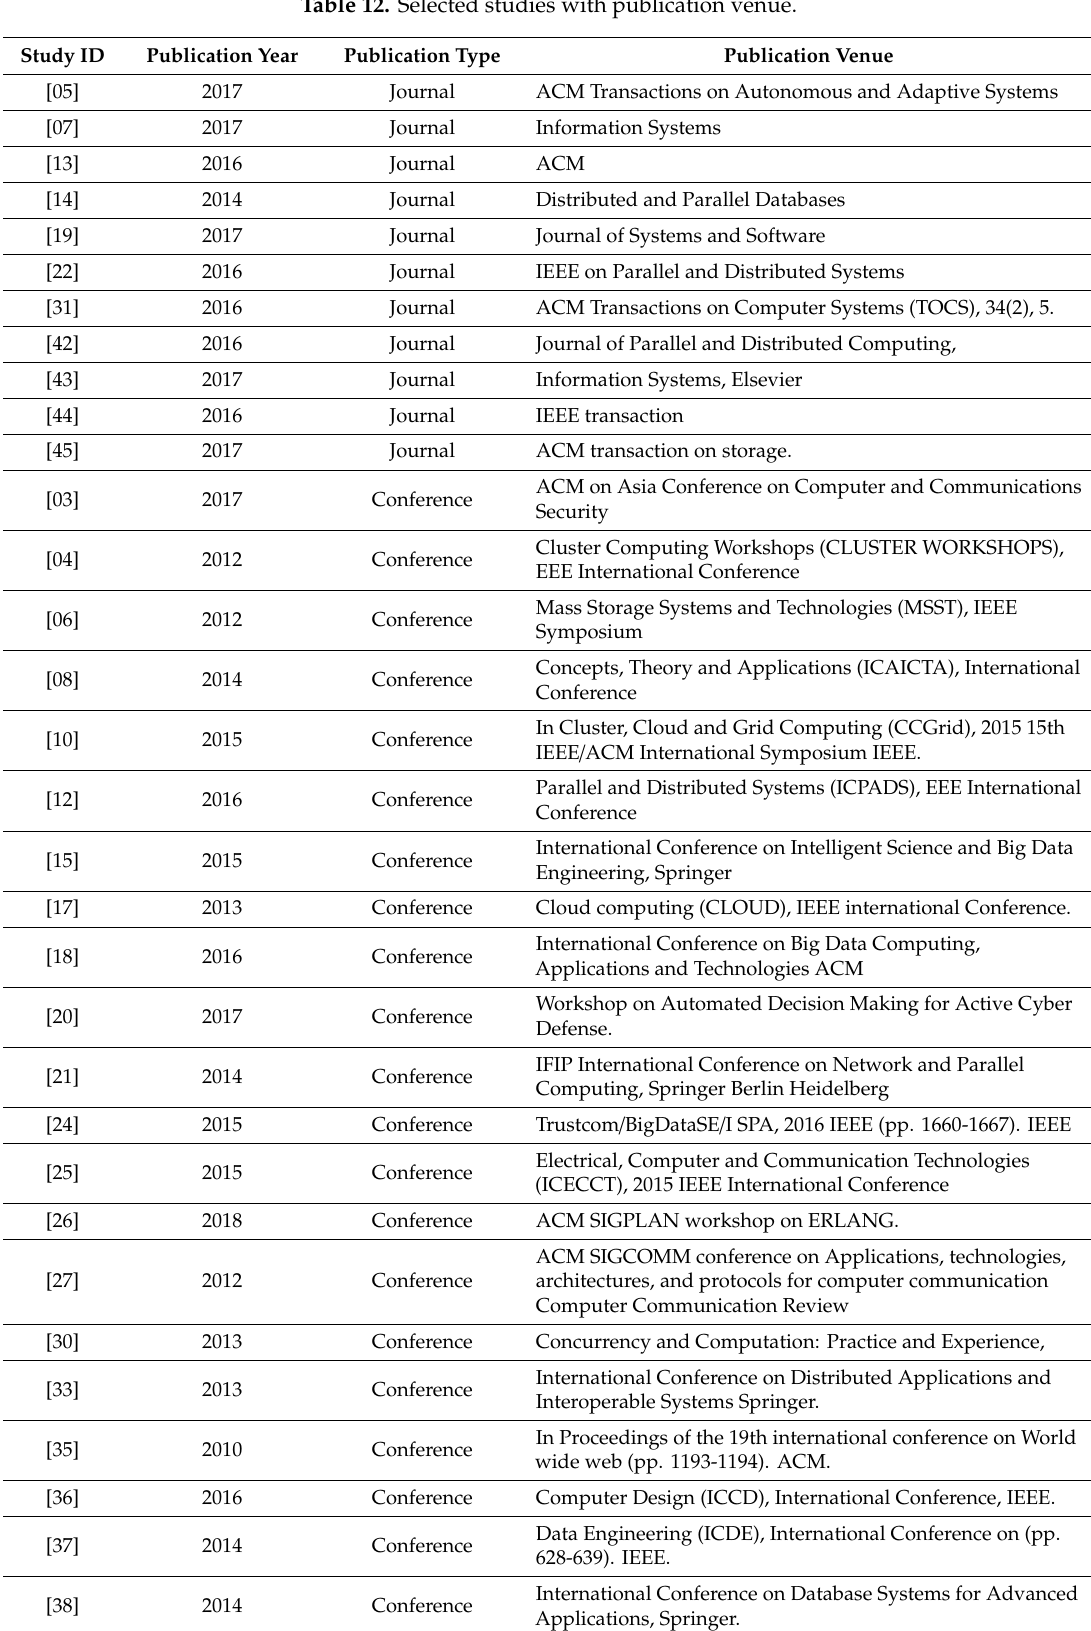
Table 12. Selected studies with publication